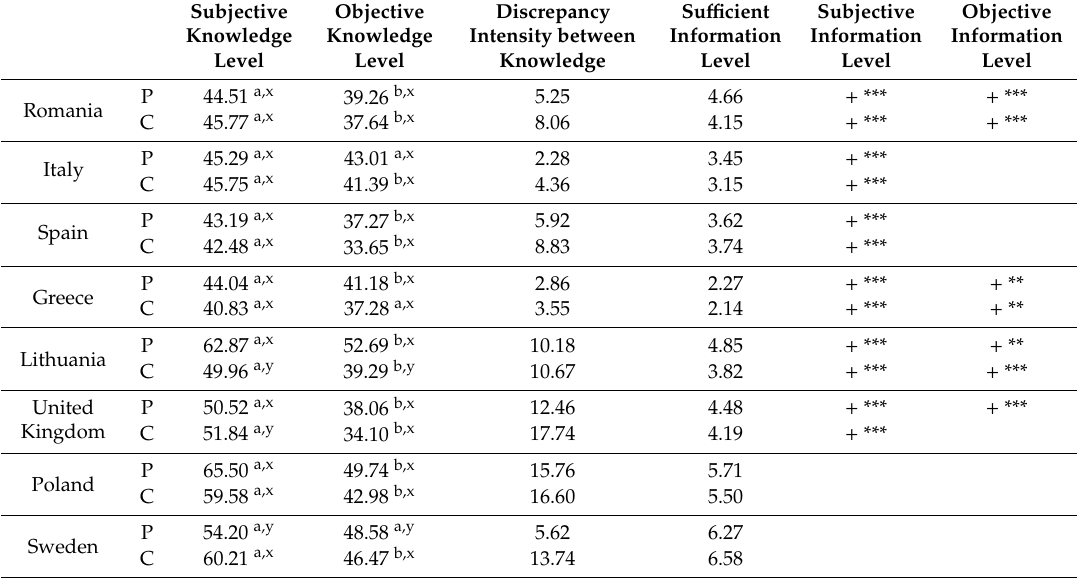
Table 2. Objective and subjective knowledge